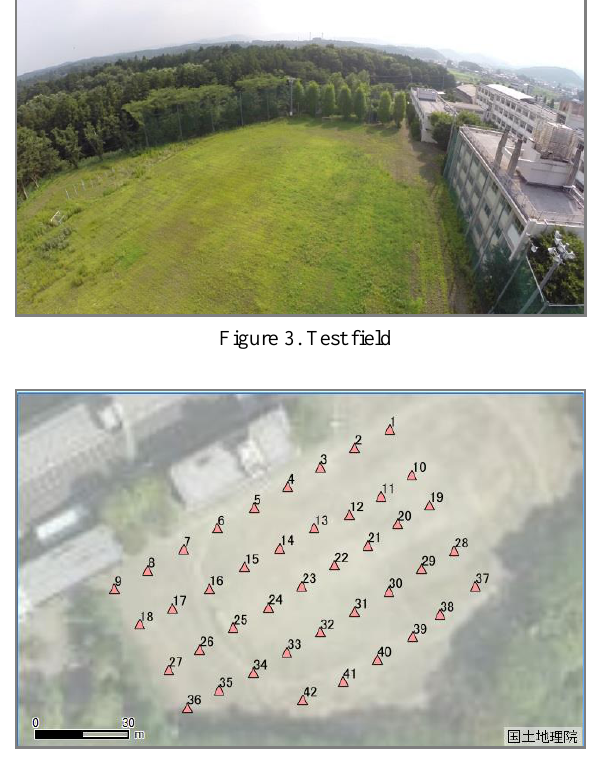
Figure 4. Configuration of test